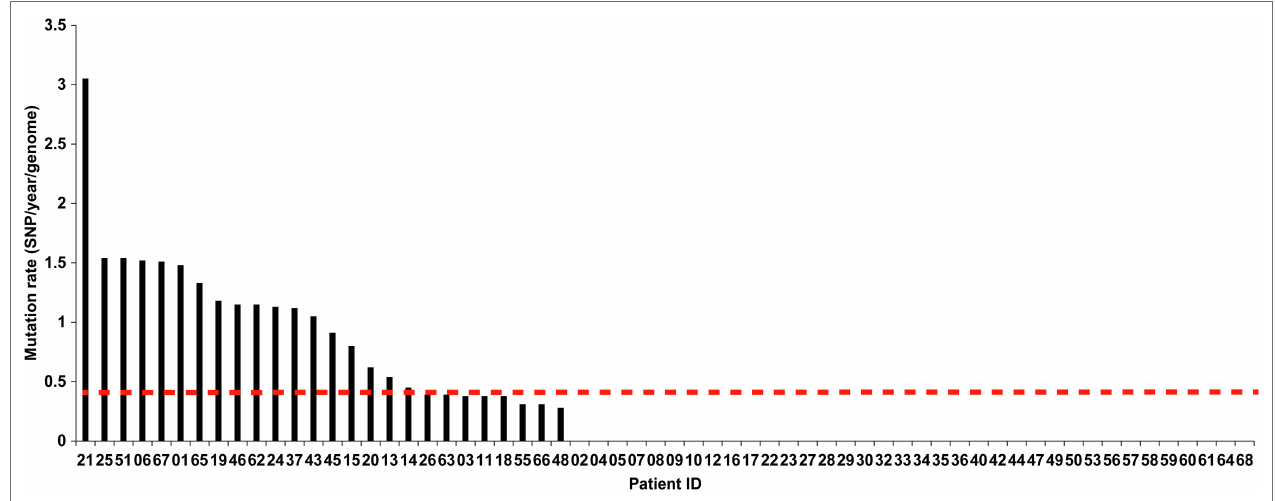
FIGURE 6 | The mutation rate of the two isolates from two episodes in relapsed patients. The X -axis indicates the patient IDs, and the Y -axis indicates the mutation rate per genome per year